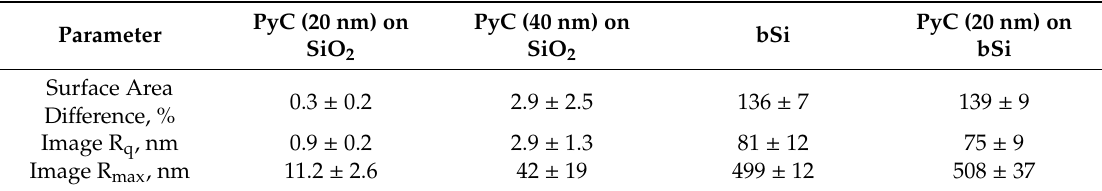
Table 1. Macroscopic and microscopic roughness of PyC (40 nm), PyC (20 nm) on SiO 2 , PyC (20 nm) on bSi and bSi (AFM images analysis).